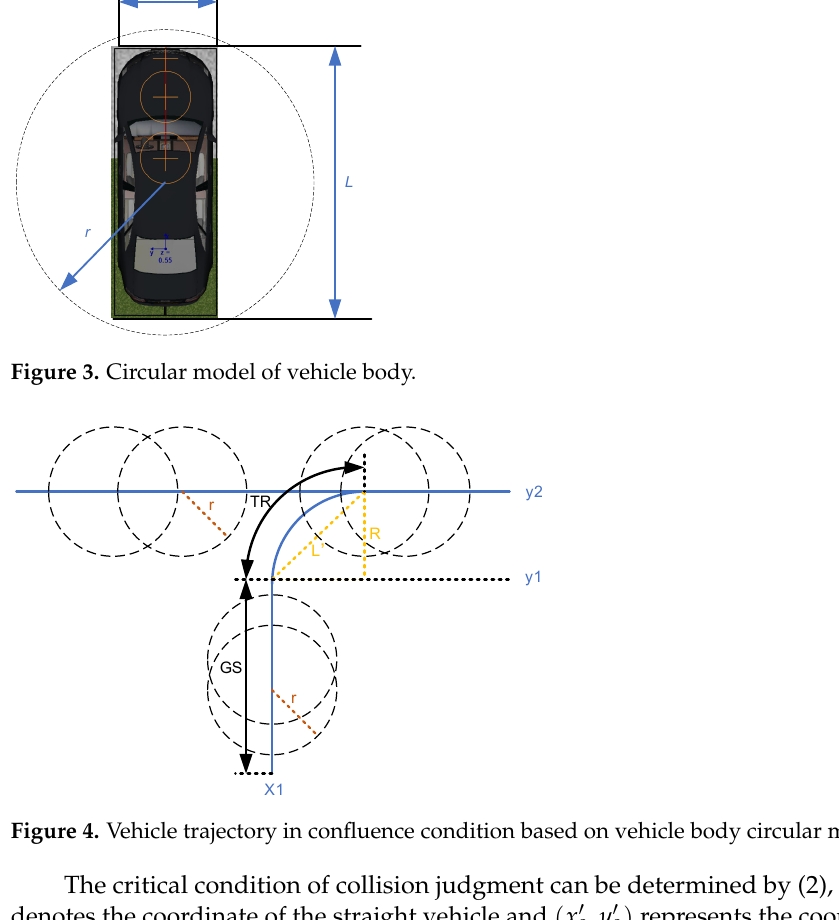
represents the coordinates of